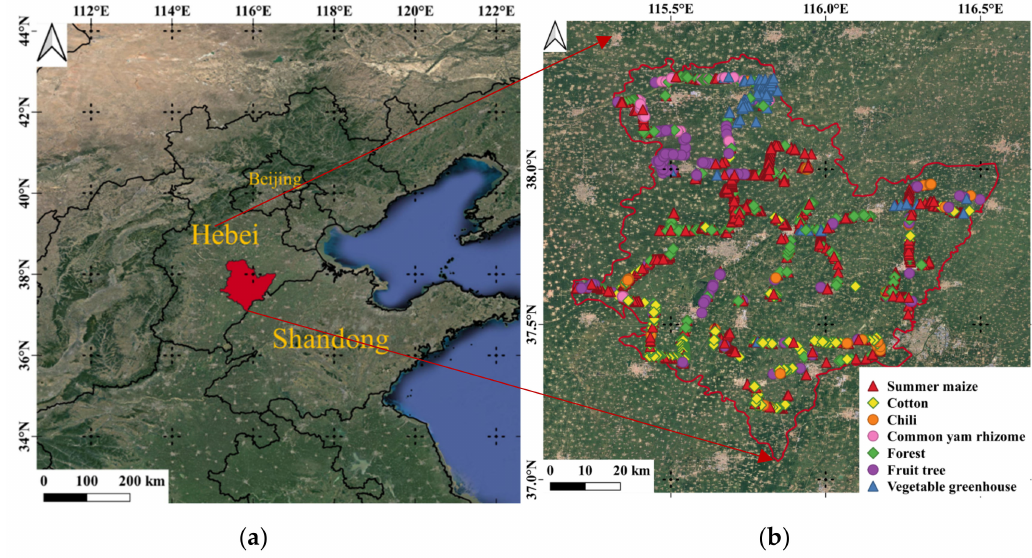
Figure 1. The study area and sample distribution: ( a ) Hebei Province; ( b ) Samples in Hengshui.